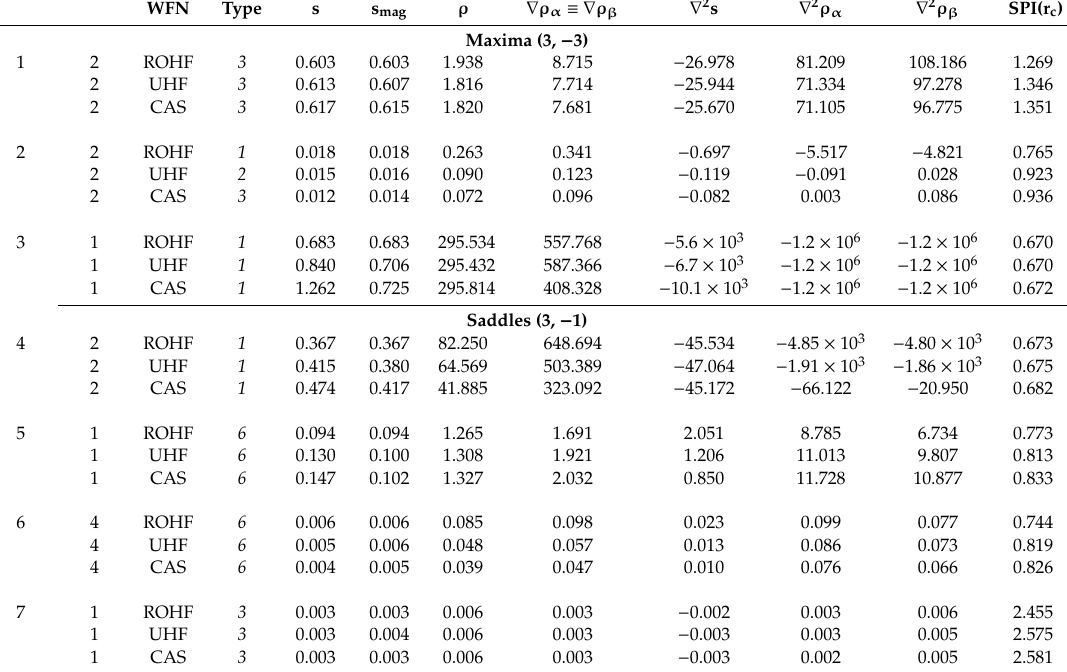
Table 2. Selected properties 1 at the (3, − 3) and (3, − 1) critical points of the 3 B 1 H 2 O molecule for various wavefunction